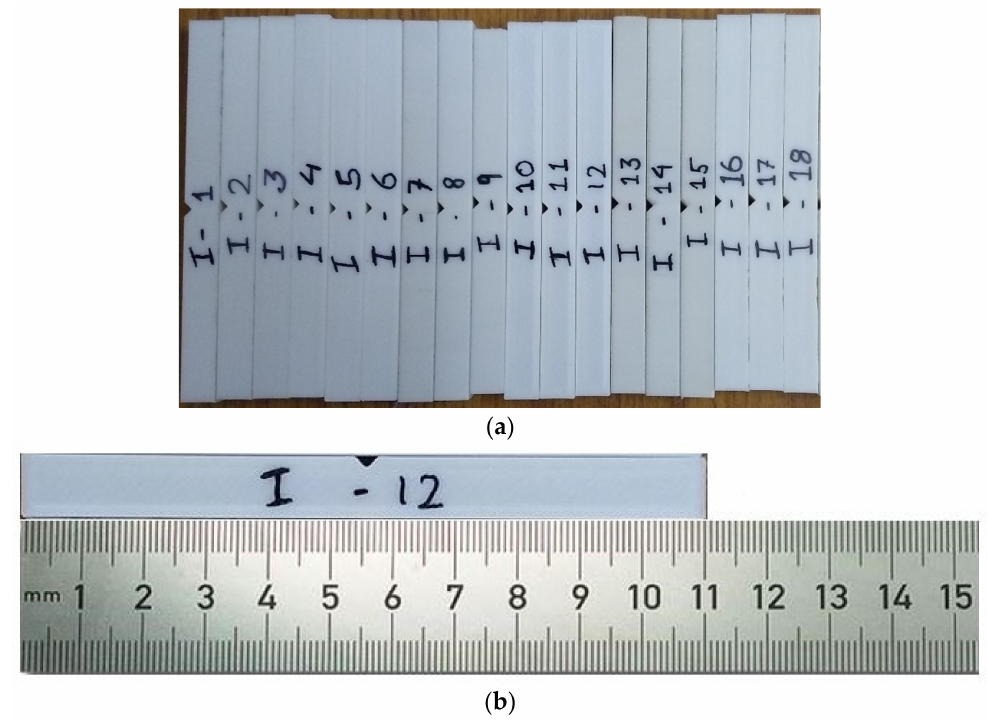
Figure 10. ( a ) Printed specimens for impact test as per the experimental design. ( b ). Impact specimen with scale.